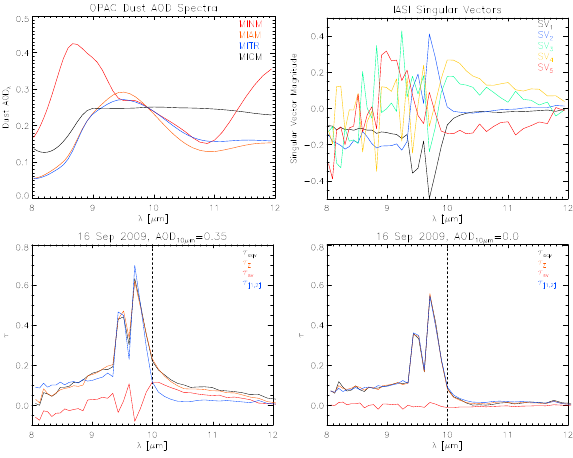
Fig. 2. Dust AOD spectra for four dust types from the OPAC database (top left), leading five singular vectors obtained from IASI observations (top right) and example spectra of different retrieval steps for dust (bottom left) and dust free (bottom right) observations. The positions of the example observations are indicated by the arrowsinthebottomrightimageofFig.3.